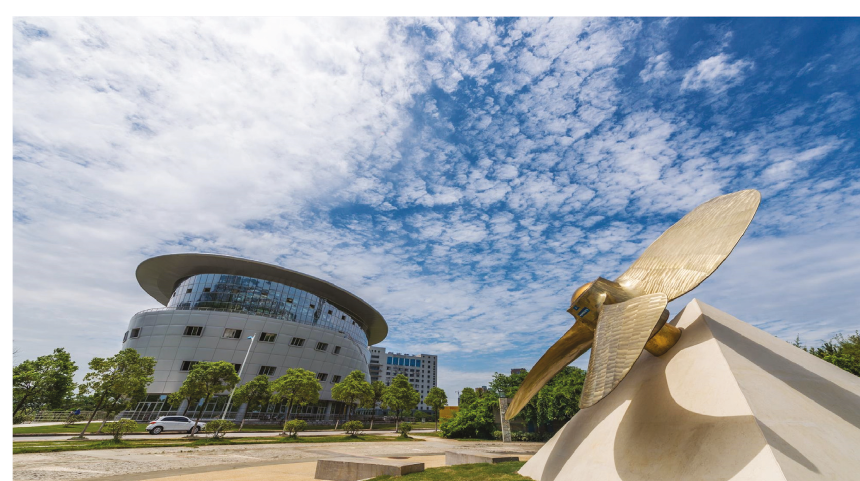
Figure 3: Ashore marine engine room 1.